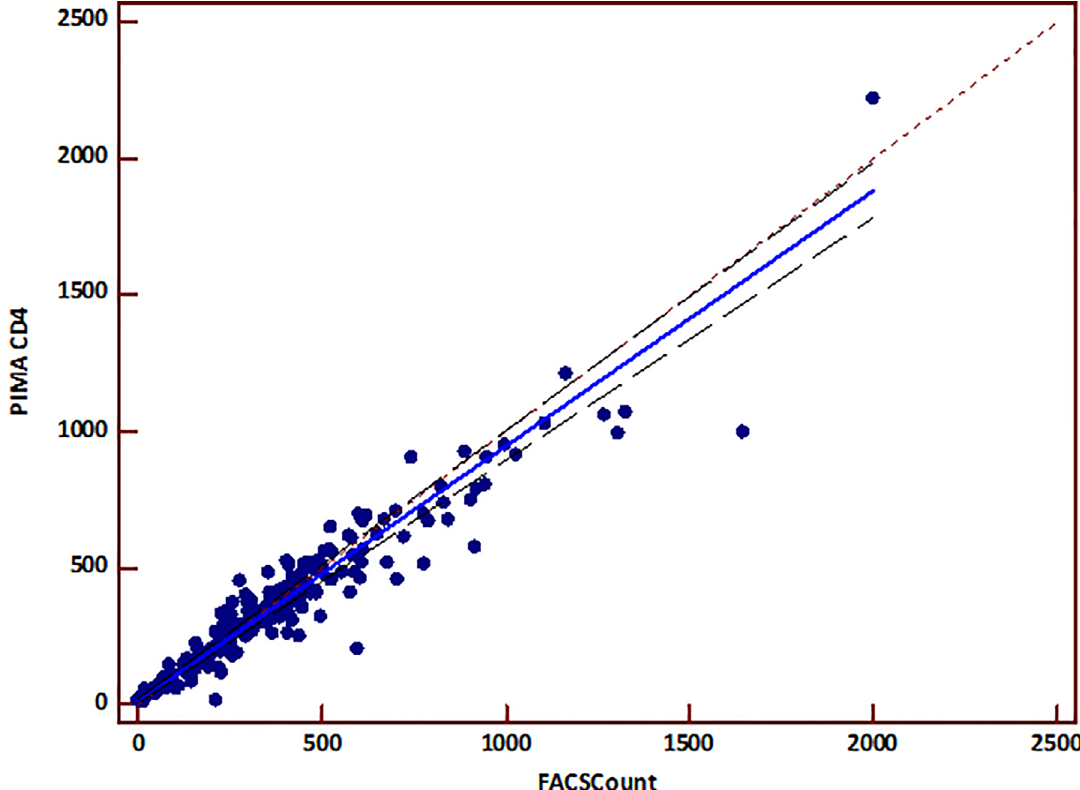
Fig 4. Passing-Bablok regression between PIMA TM Alere CD4 and BD FACSCount TM . The x-axis represents CD4 counts provided by the BD FACSCount TM reference and the y-axis represents the CD4 counts provided by the PIMA TM CD4. The solid line represents the regression line, and the dashed line represents the line y = x. The linear equation of the regression is y = 0.9347 x +